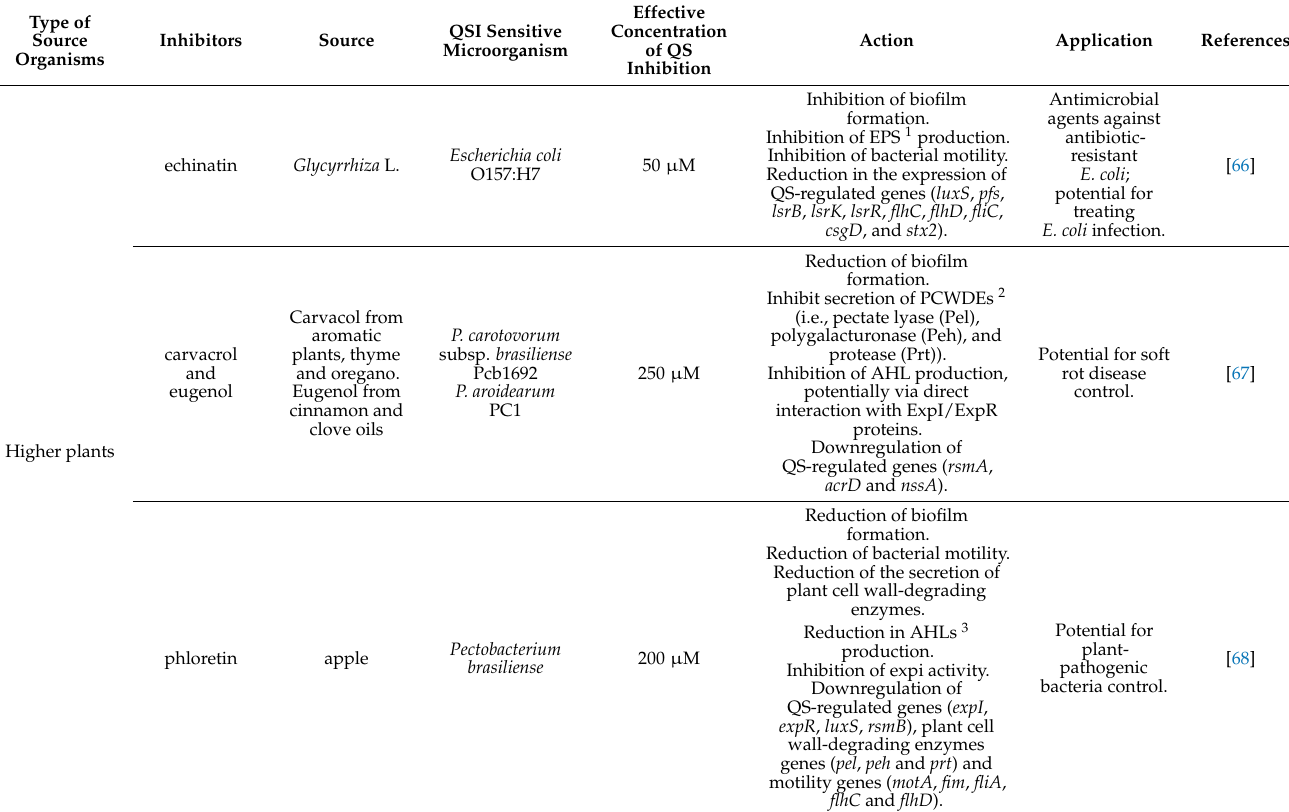
Table 1. Mode of action of selected natural and synthetic QS